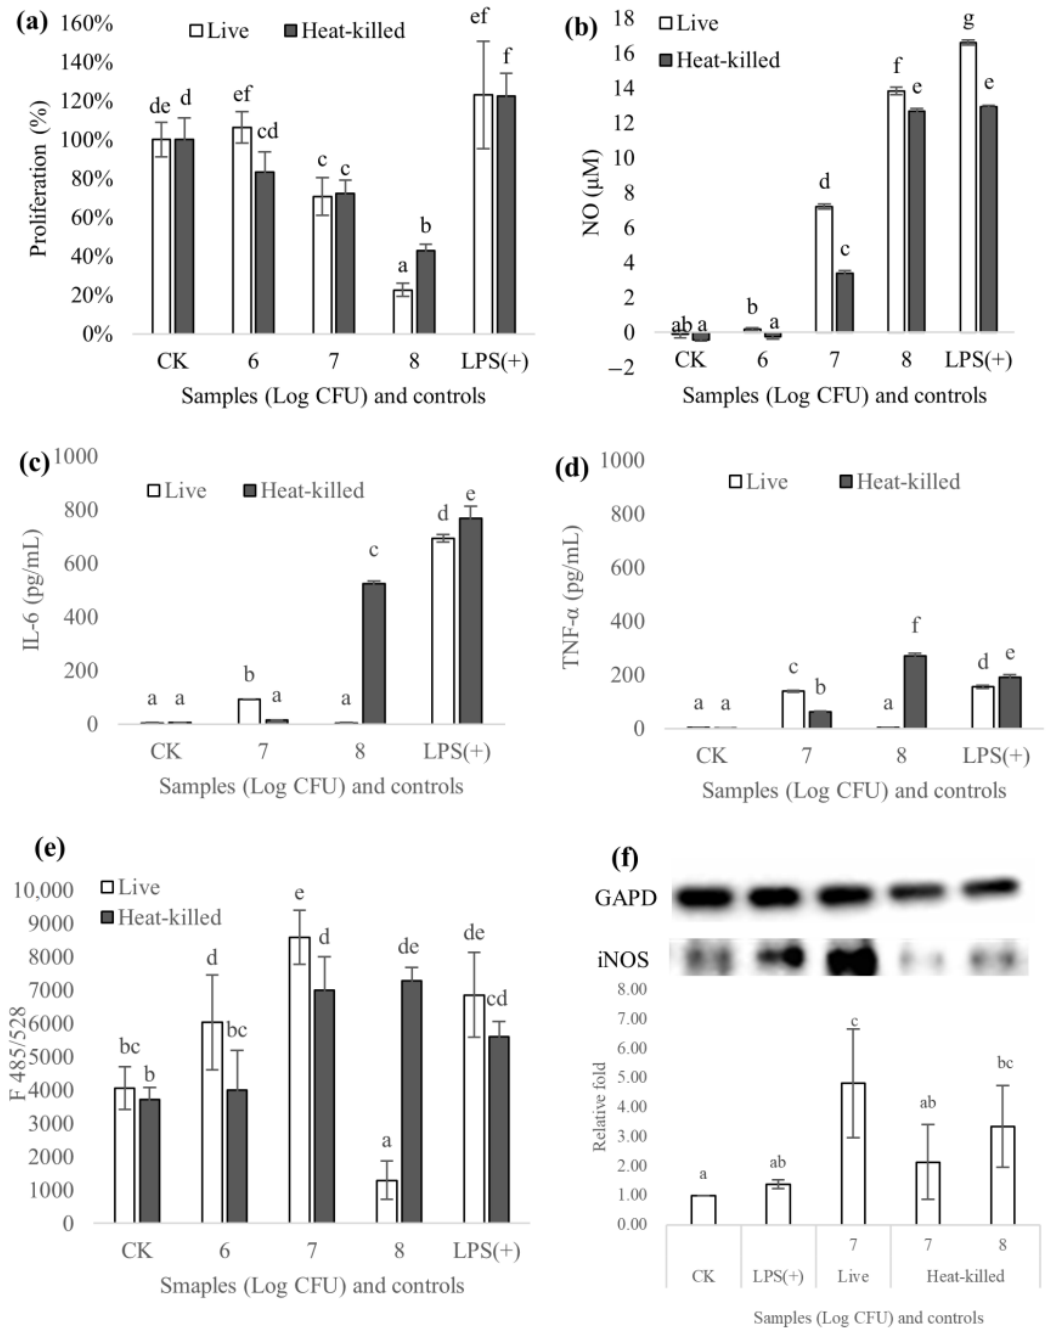
Figure 7. Results of proliferation ( a ), NO ( b ), IL-6 ( c ), TNF- α ( d ), ROS ( e ), and iNOS